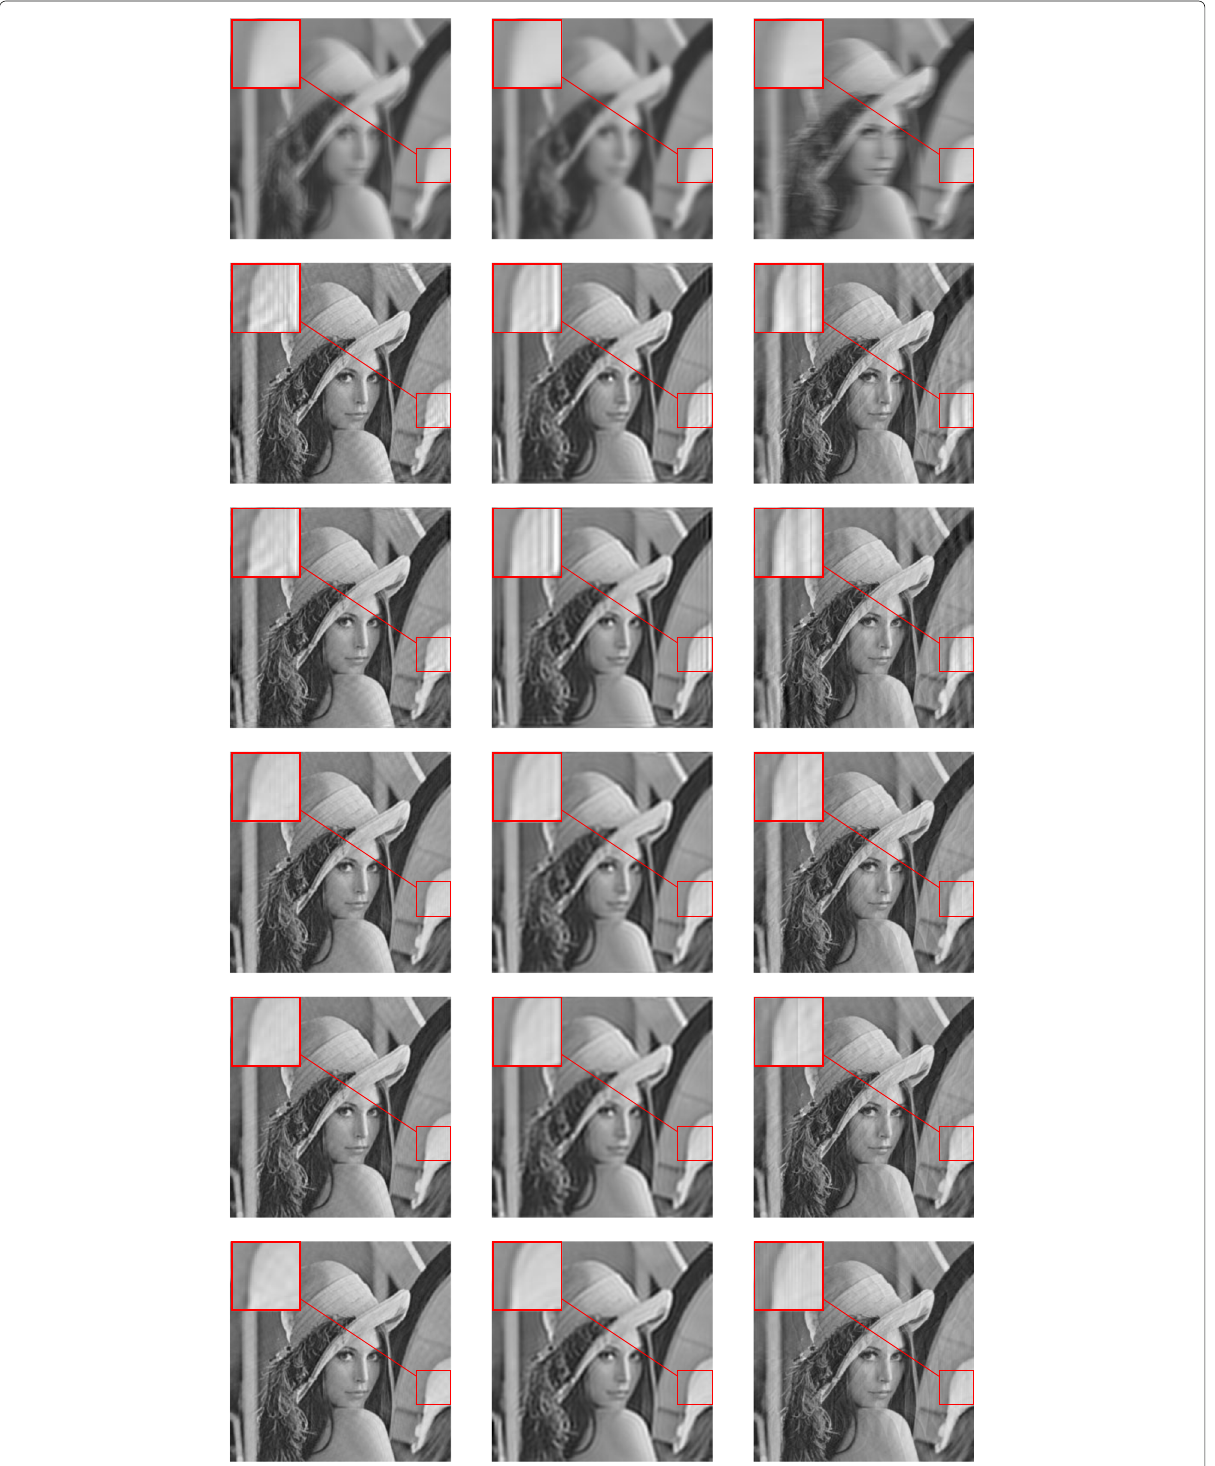
Fig. 3 Deconvolution of Lena image. From left to right, the first column represents degradation by kernel 1, the second column for the degradation by kernel 2, and by kernel 3 in the third column. From top to bottom, the order of the rows is as follows: blurred images using the three kernels respectively, restored images using RL algorithm [11] (kernel 1 (iterations = 100), kernel 2 (iterations = 200) and kernel 3 (iterations = 40)), restored images using Wiener filter [9], restored images using TV method [14], restored images using BTV approach [16], and finally the restored images using our proposed MAP- H 1